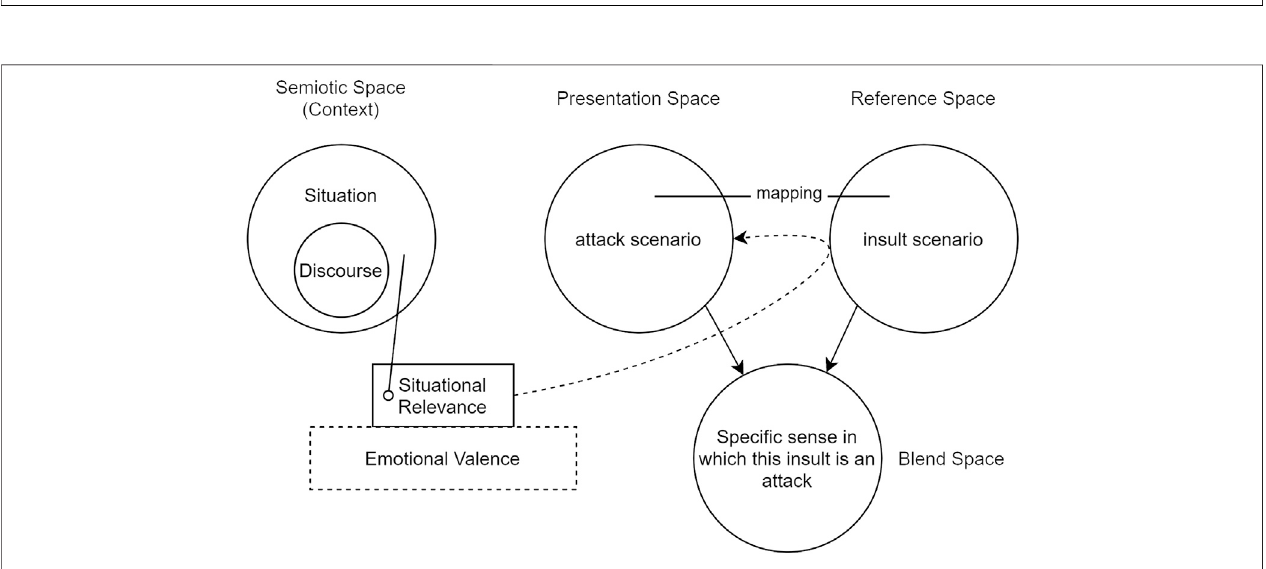
FIGURE 5 | Selective projection in a situation in which an insult is interpreted as an attack. Situational relevance is determined by the emotional valence of the current action. Figure based on context-dependent blending theory by Brandt and Brandt (2005), and adapted from Li et al. (2012).